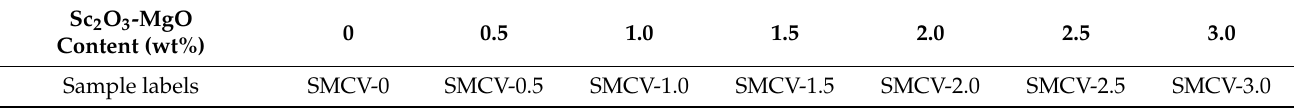
Table 3. The sample labels of electrospun